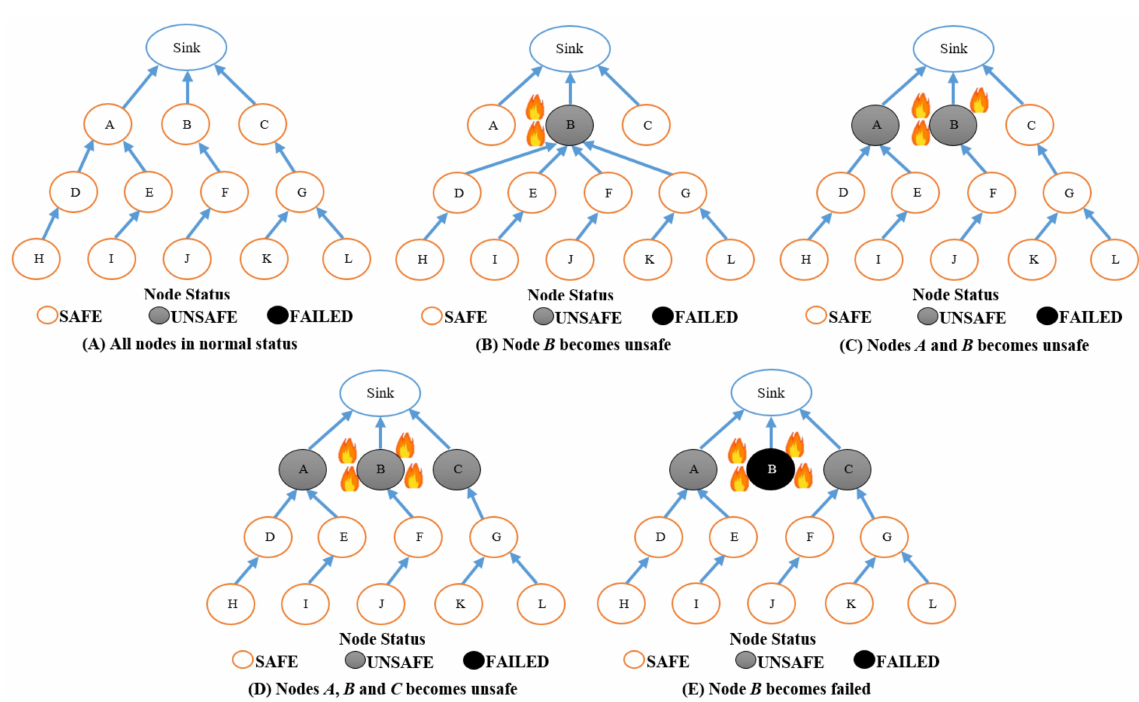
Figure 9. The diagram of the proposed LARRR